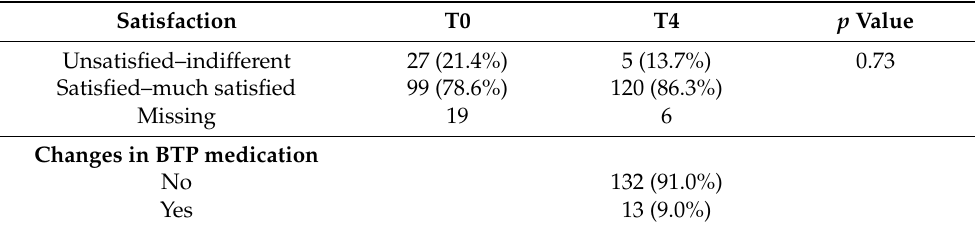
Table 5. Satisfaction with BTcP